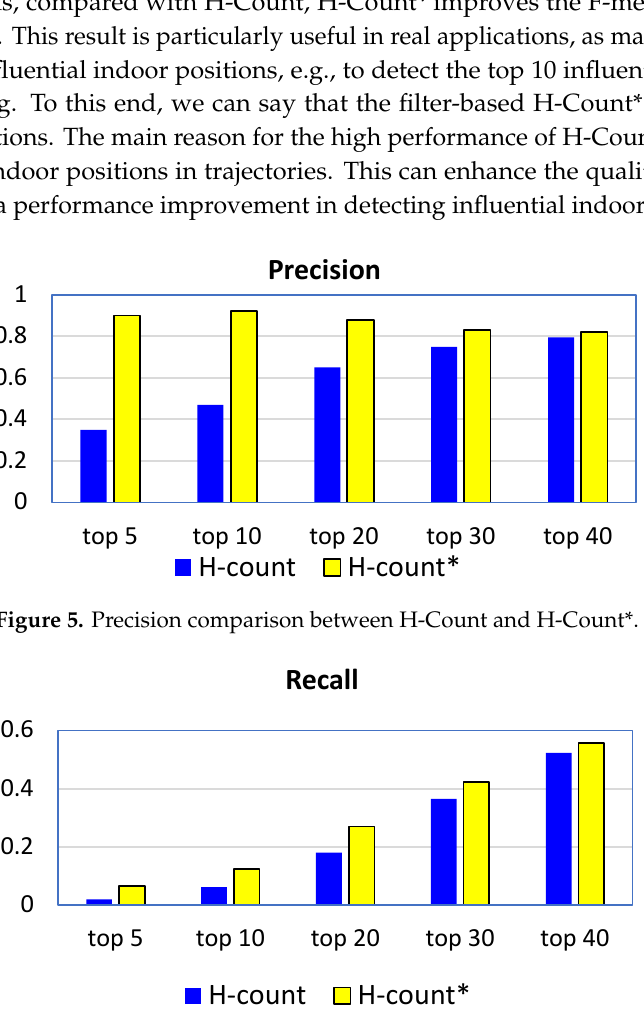
Figure 6. Recall comparison between H-Count and H-Count*.